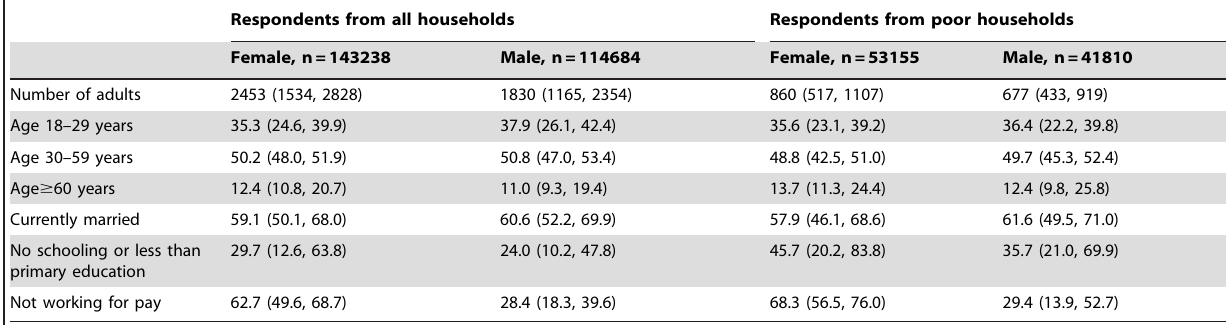
Respondents from all households Respondents from poor households